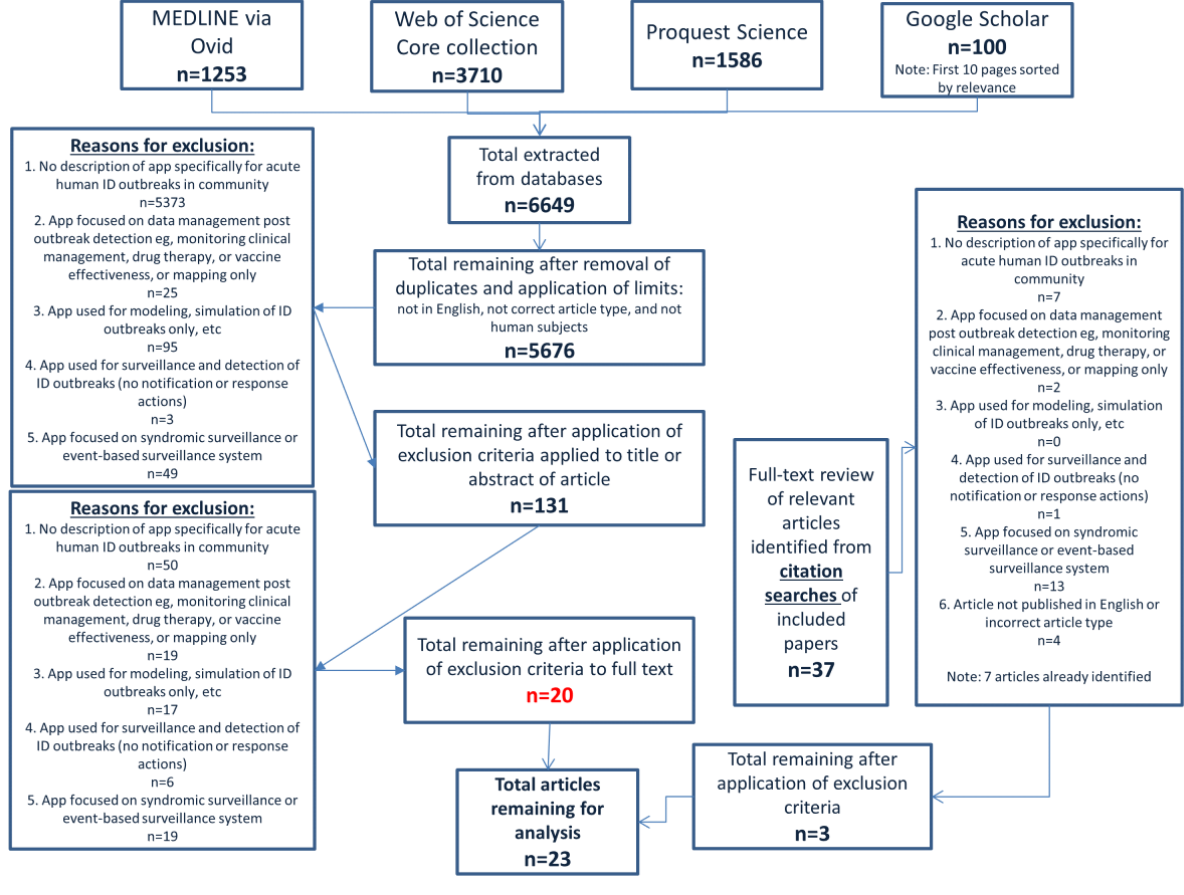
title and abstract and 131 remained for full-text review (Figure